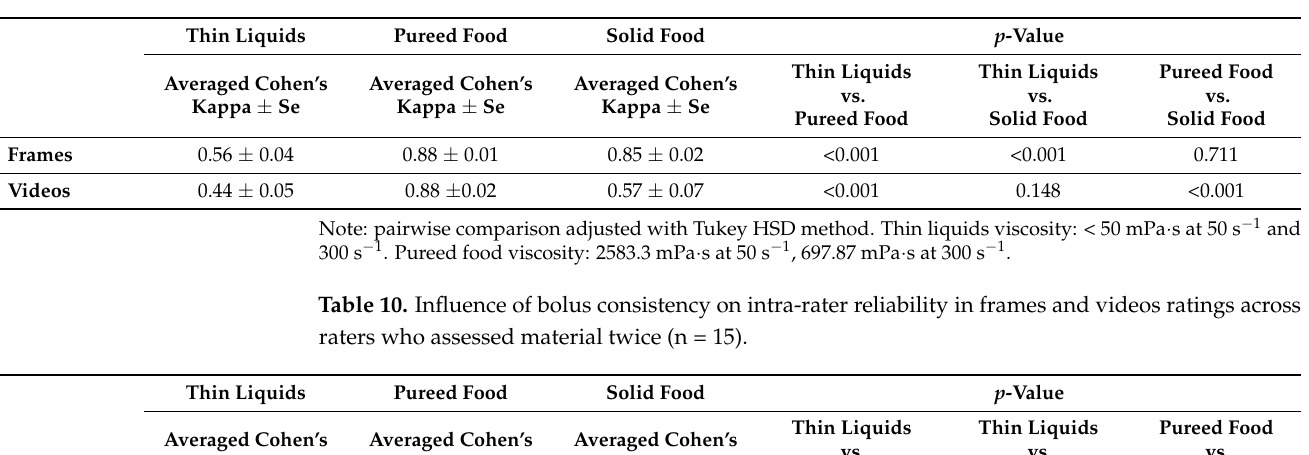
Table 9. Influence of bolus consistency on construct validity in frames’ and videos’ ratings across all the raters (n = 29).